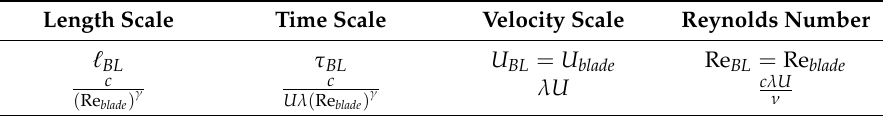
Table A1. Table A1. Characteristic blade scales in VAWT Table A1. Characteristic blade scales in VAWT turbines.